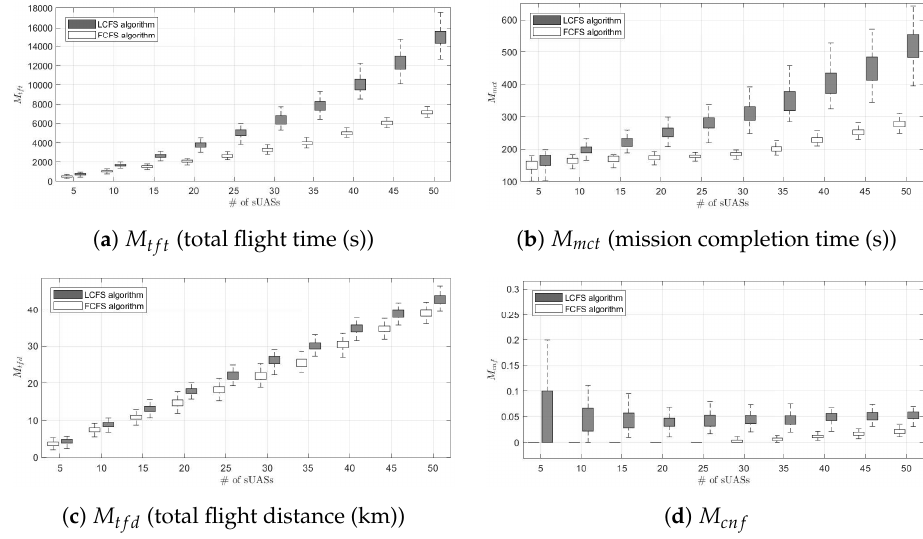
Figure 11. M -to-1 Case: Standard deviation comparisons between the FCFS algorithm and the LCFS algorithm for M tft , M mct , M tfd , and M cnf .